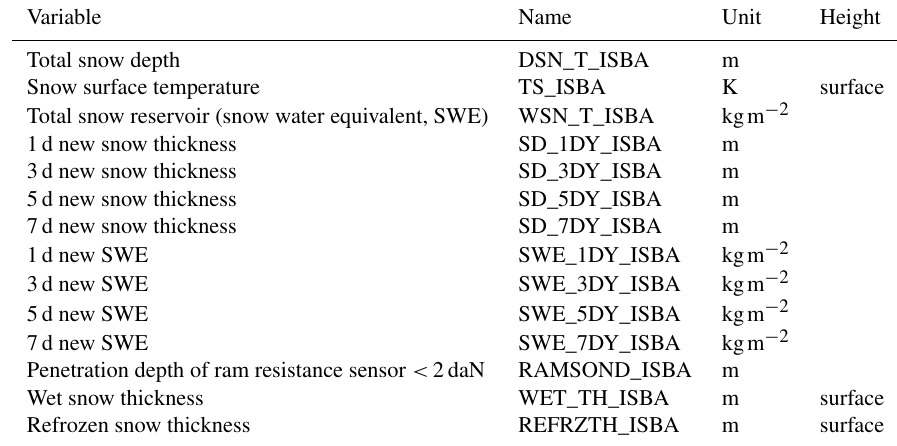
Table 4. List of instantaneous snowpack variables (at 06:00UTC) included in the S2M reanalysis.